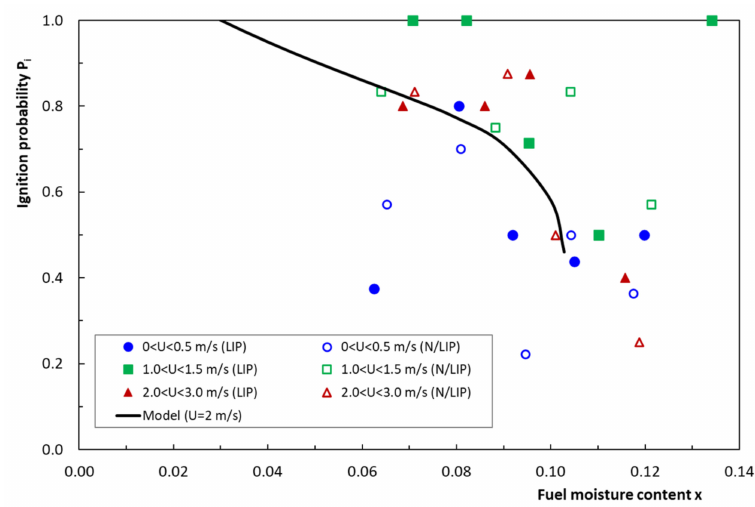
Figure 16. Average values of probability of ignition P i as a function of the fuel bed moisture content x for different values of airflow velocity U for tests with Lower Ignition Propensity (LIP), No Lower Ignition Propensity (N/LIP) and butts; comparison with model prediction (Equation